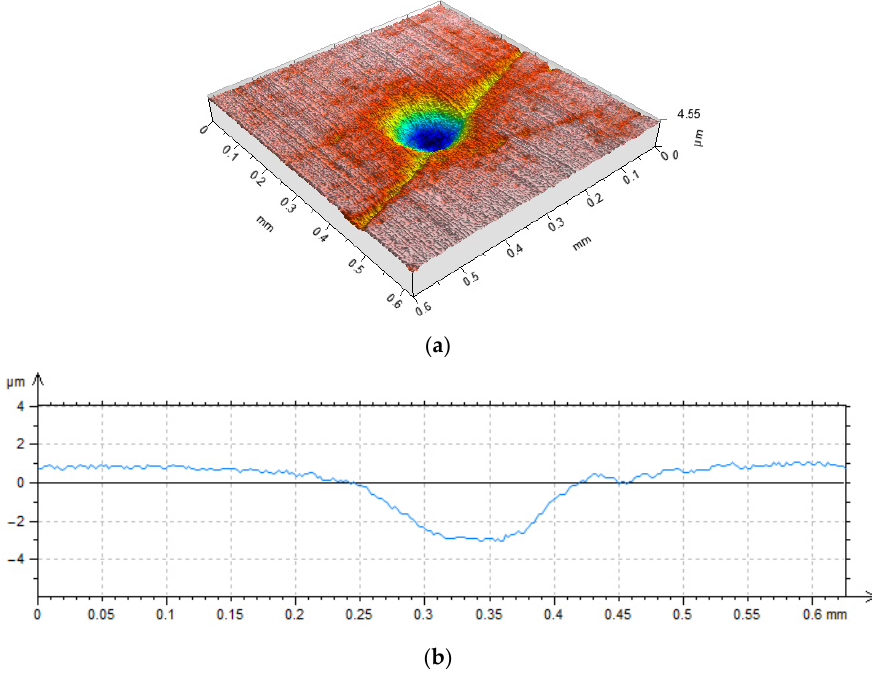
Figure 21. View ( a ) and profile ( b ) of the dimple of the cylinder surface used in [123]. Rao et al. [29] studied the effect of the texture of the liner surface texturing on wear, Nox emission, and engine vibration. Cylinder liners were made of boron cast iron. The thread grooves on the CNC machined liner surface had widths of 1, 2, and 3 mm (Figure 22) and depths of around 0.2 mm. The alternative was to combine these grooves with dimples made on the first piston ring by laser. The diameter of the dimple was 1 mm, and the depth was 0.115 mm. It was found that the presence of the grooves could reduce the wear of the liner and the ring, the Nox emissions (more than 10%), and the violent vibration of the engine. The best parameters were obtained for grooves of 2 mm width. The test duration was 6 h. The storage of lubricant within valleys caused small wear on the analyzed system. Smaller Nox emissions can be explained by better sealing of the textured assembly, as the burned gas was expelled more quickly. The stored lubricant had a positive effect on damping.